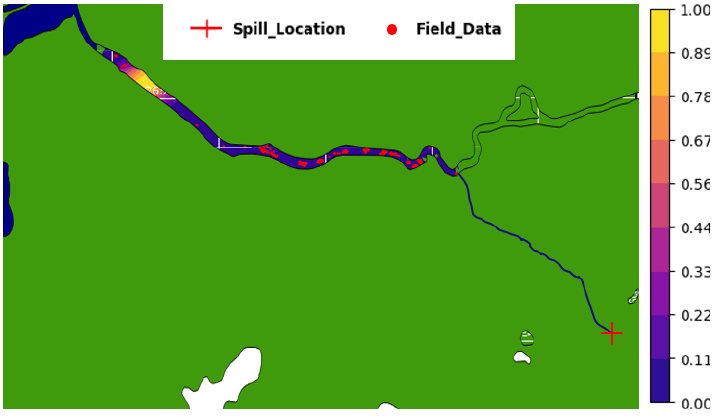
Figure 8. SOSim’s 1-D model result on 26 September 2010 shown in 2-D along Kalamazoo River. Field data from 29 August to 21 September 2010 that were input to SOSim are shown as red dots.